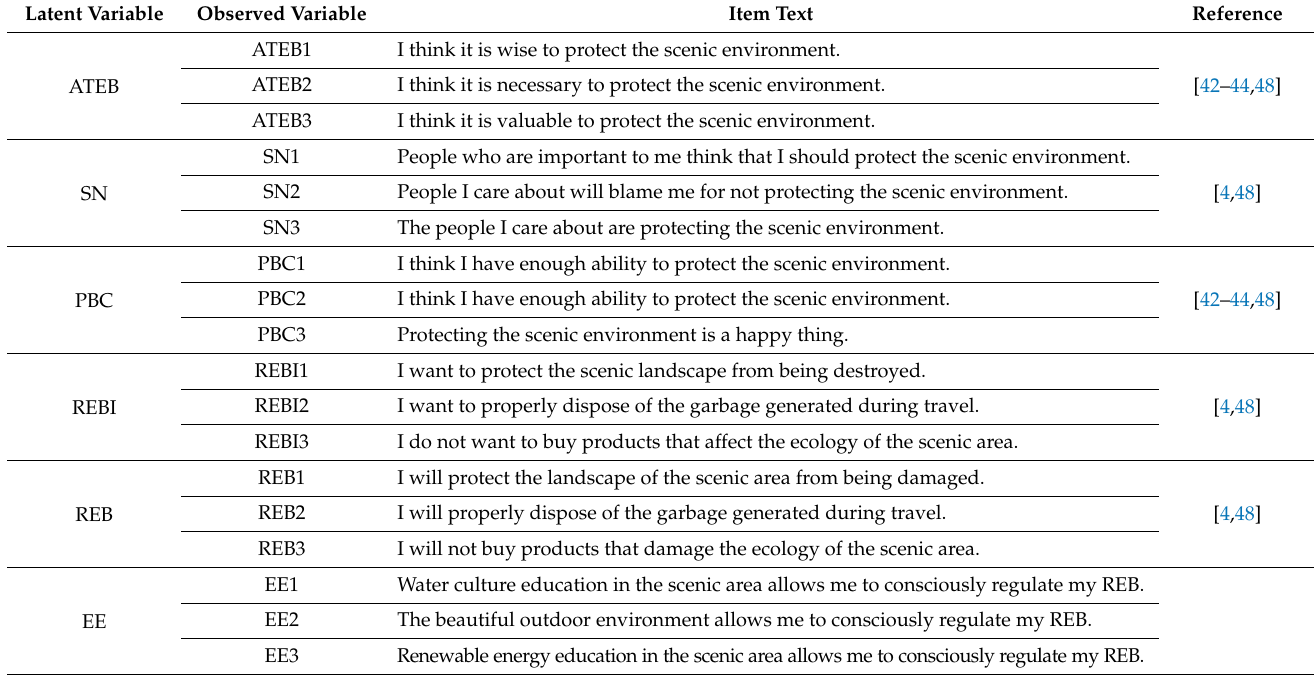
Table 3. Constructs and scale used in the